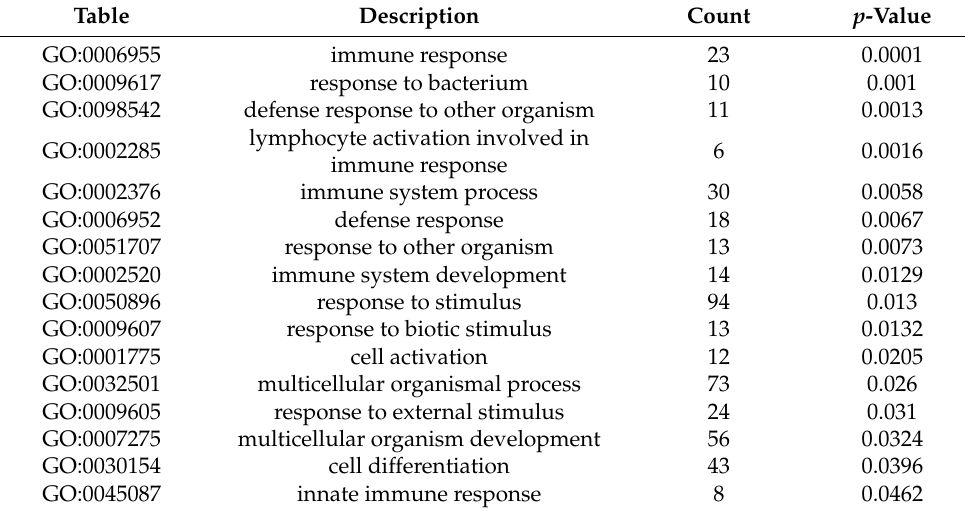
Table 1. Immune-related biological processes identified by gene ontology analysis of DEGs in